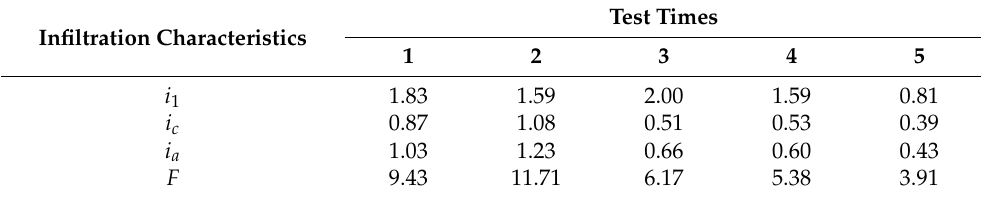
Table 1. Characteristics of soil water infiltration. Infiltration Characteristics